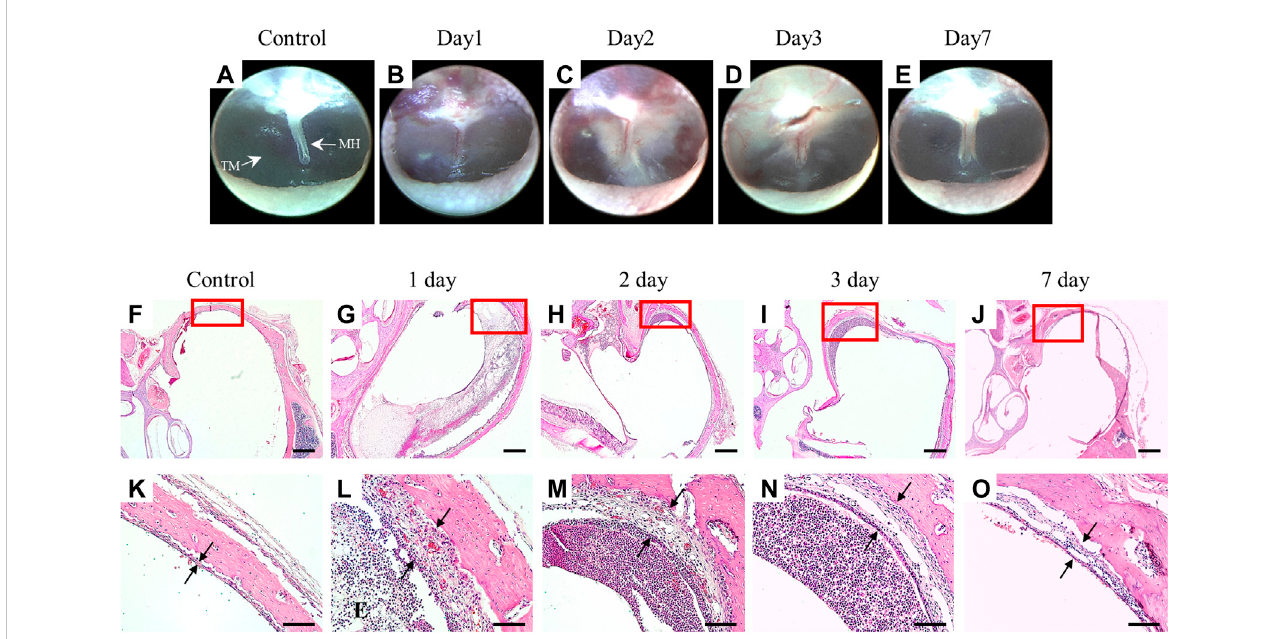
FIGURE 1 Establishment of a rat model of OM induced by LPS injection through the tympanic membrane. Otoscope images of the tympanic membrane after LPS injection (A – E) . ME mucosa stained with H&E, magni fi cation ×2.5 (F – J) and ×20 (K – O) . Scale bars indicate 500 µm (F – J) and 100 µm (K – O) . MH: malleus handle, TM: tympanic membrane, E: